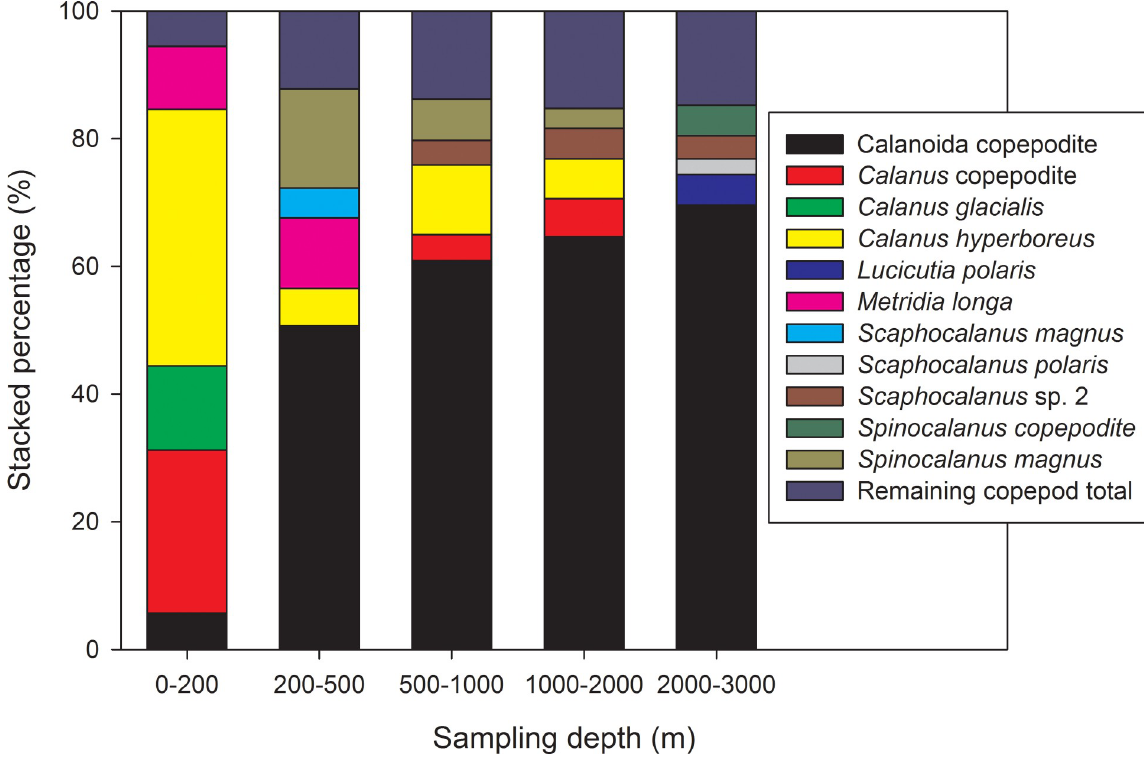
Fig 5. Relative abundance of the five most abundant copepod species identified from five different sampling